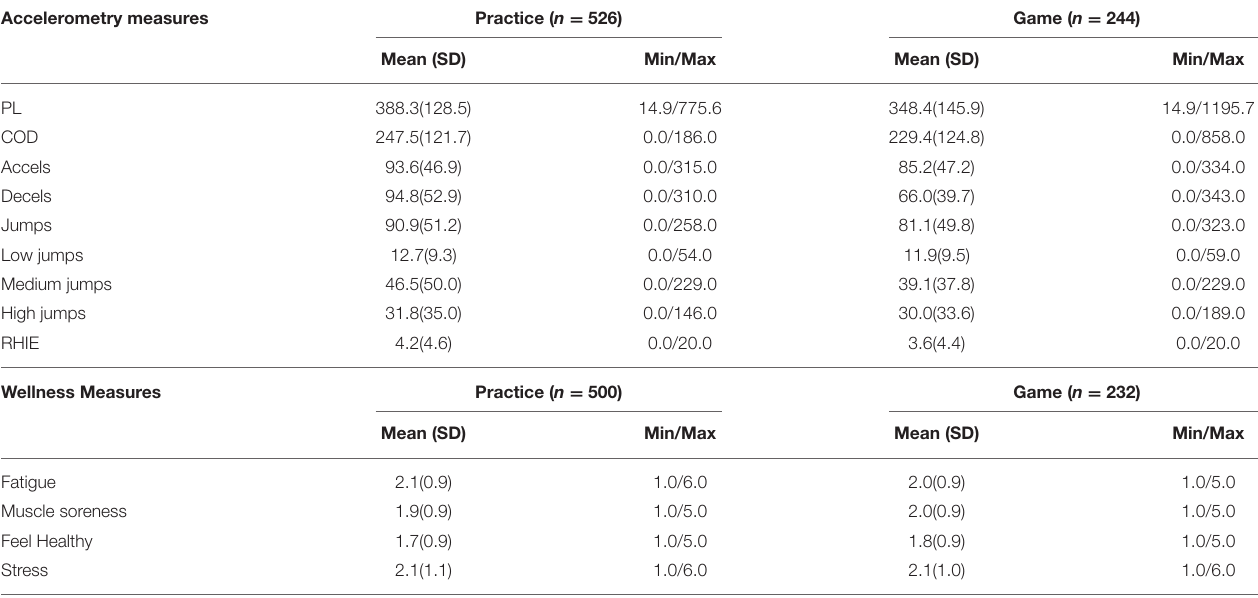
TABLE 2 | Mean and standard deviation of microsensor and wellness measures for all athletes per session